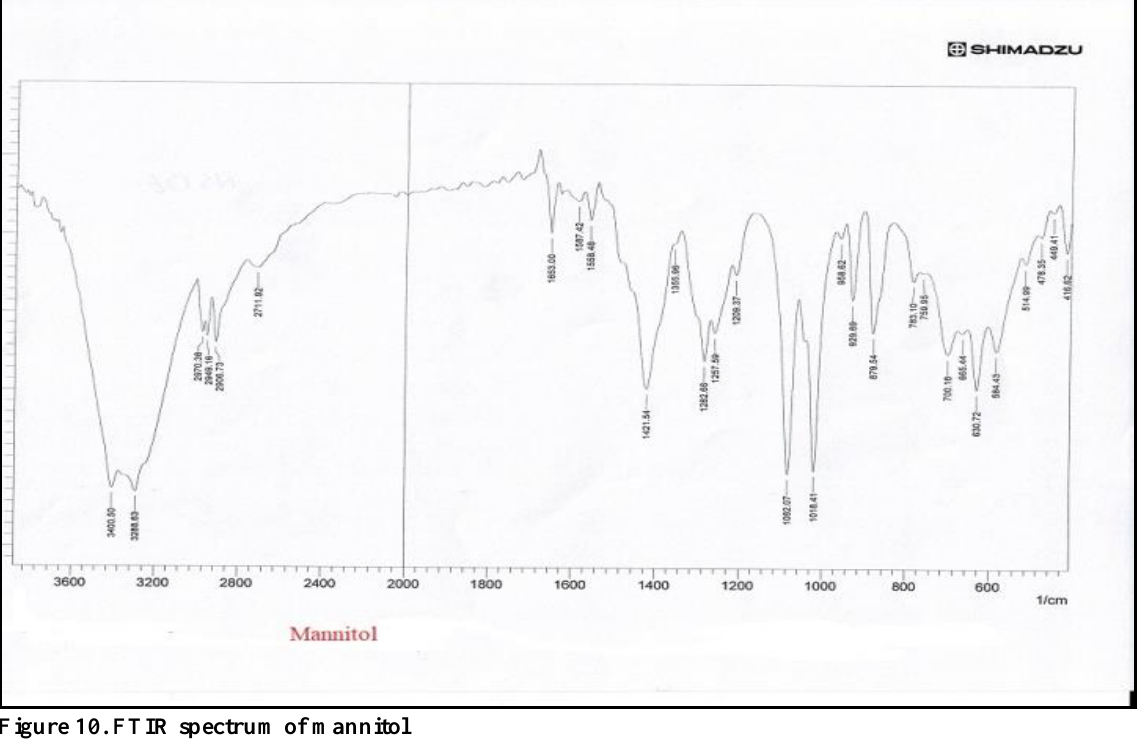
Figure 10. FTIR spectrum of mannitol